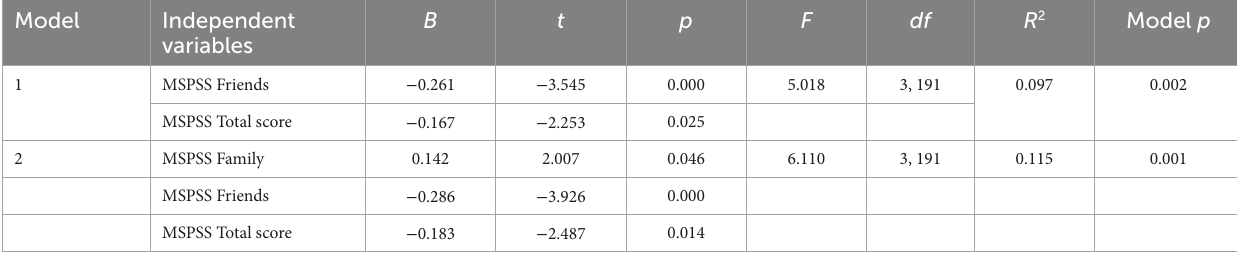
TABLE 4A A Hierarchical regression analyses of MSPSS dimensions. Model